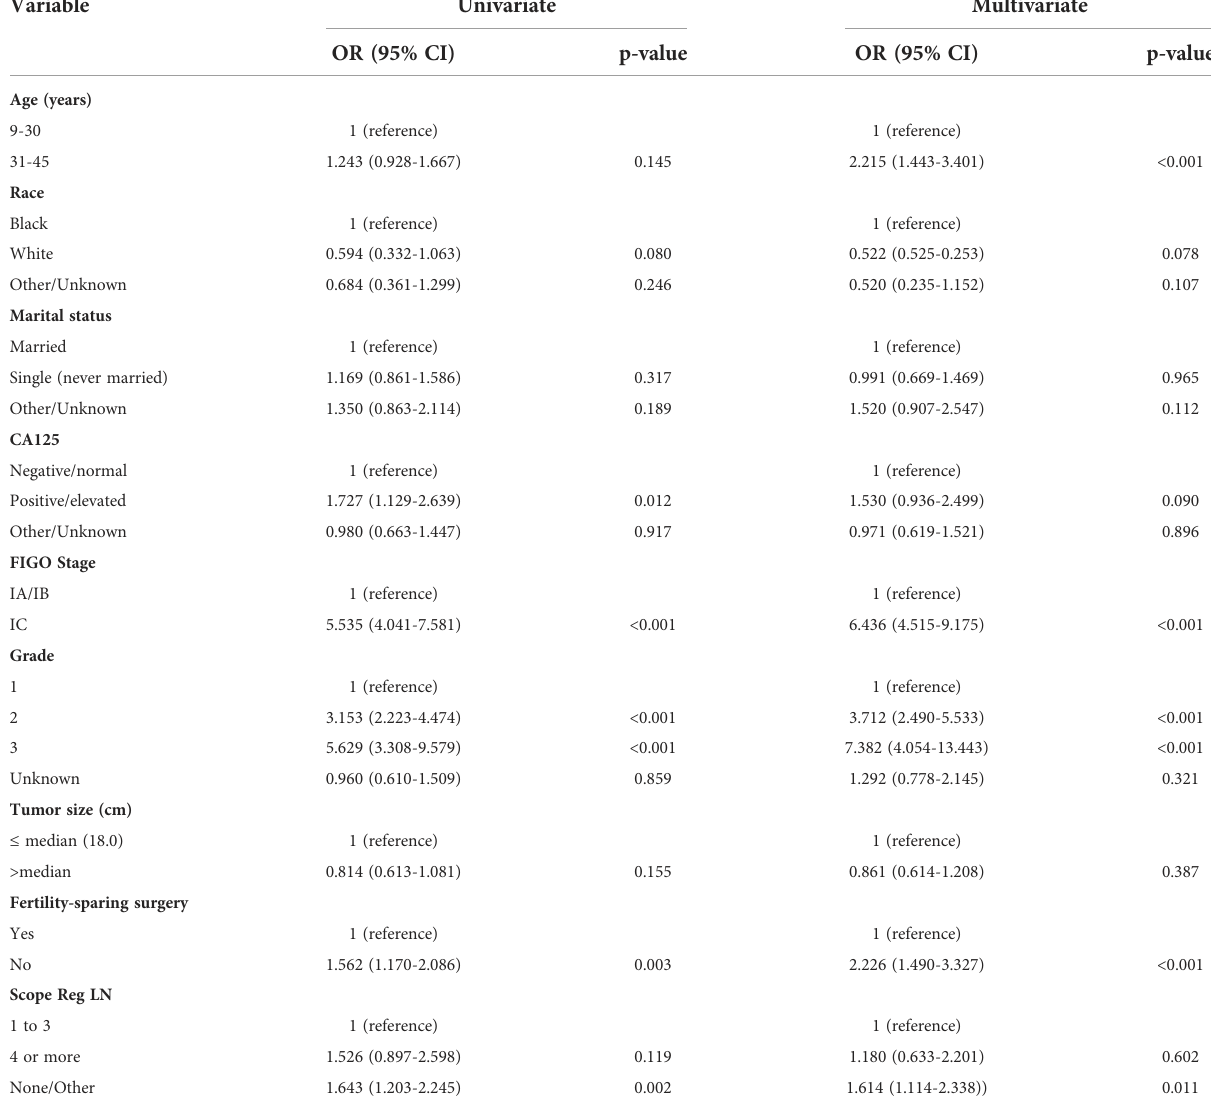
TABLE 2 Logistic regression for associations between patient characteristics and